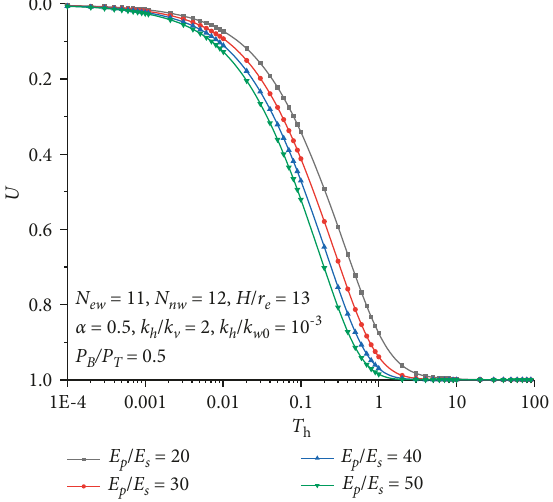
Figure 6: Influence of pile-soil compression modulus ratio on foundation consolidation curve.